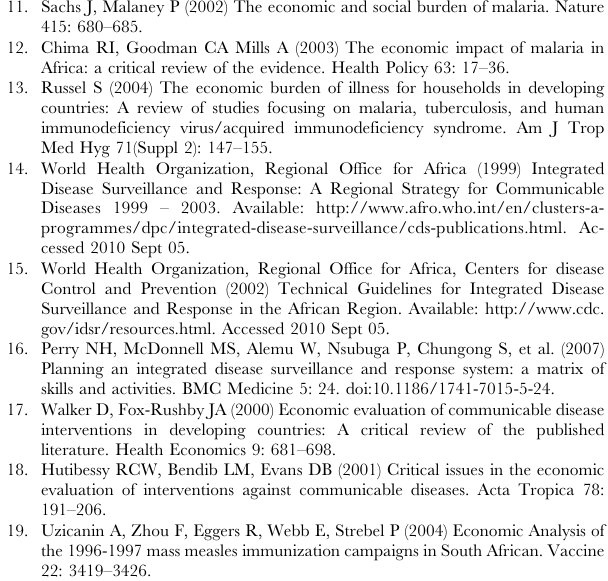
Table S4 Pattern of annual vaccines delivered to region before (1996–2002) and after (2003–2008) IDSR implementation.